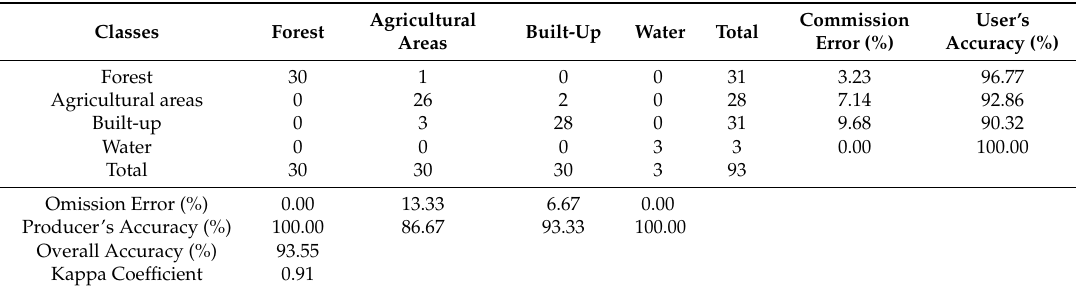
Table 6. Confusion matrix of the 2015 classification maps derived from the Landsat OLI data of MMFR Watersheds. Classes